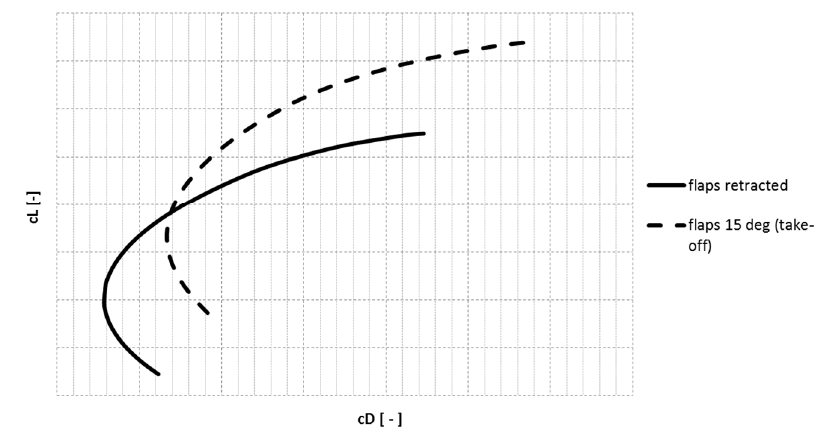
Figure 2. Polar graph of the aircraft for cruise (i.e., flaps retracted) and take-off configuration (i.e., flaps 15°).